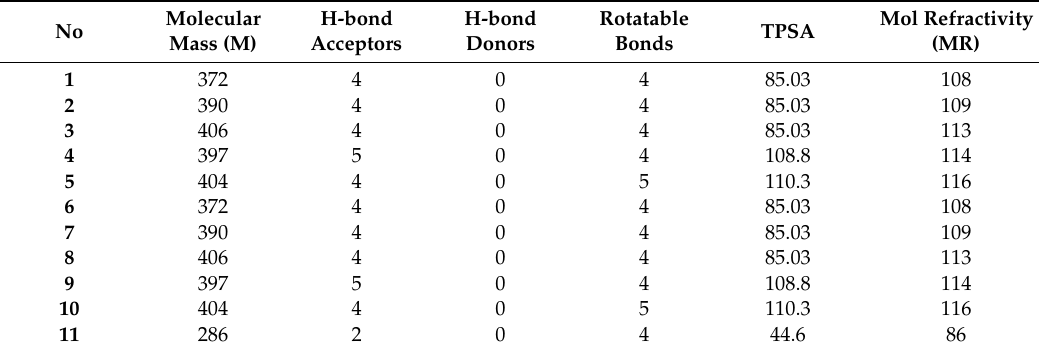
Table 3. The molecular descriptors and parameters of Lipinski’s rule for 1,2,3-triazole-dipyridothiazine hybrids ( 1–10 ) and prothipendyl ( 11 ) [32,33].